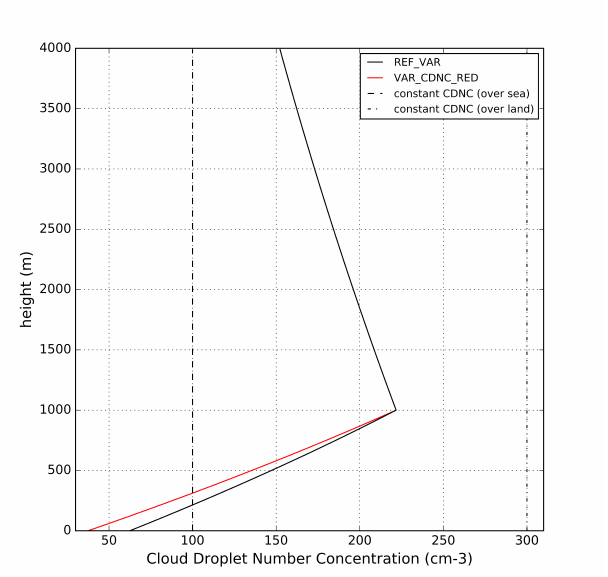
Figure 3. CDNC variation with height in a standard atmosphere. REF_VAR (black continuous line; Re = 0.25), VAR_CDNC_RED (red continuous line; Re = 0.15). The constant CDNC values over the sea (100 cm − 3 ; dashed line) and land (300 cm − 3 ; dashed-dotted line) are also shown for